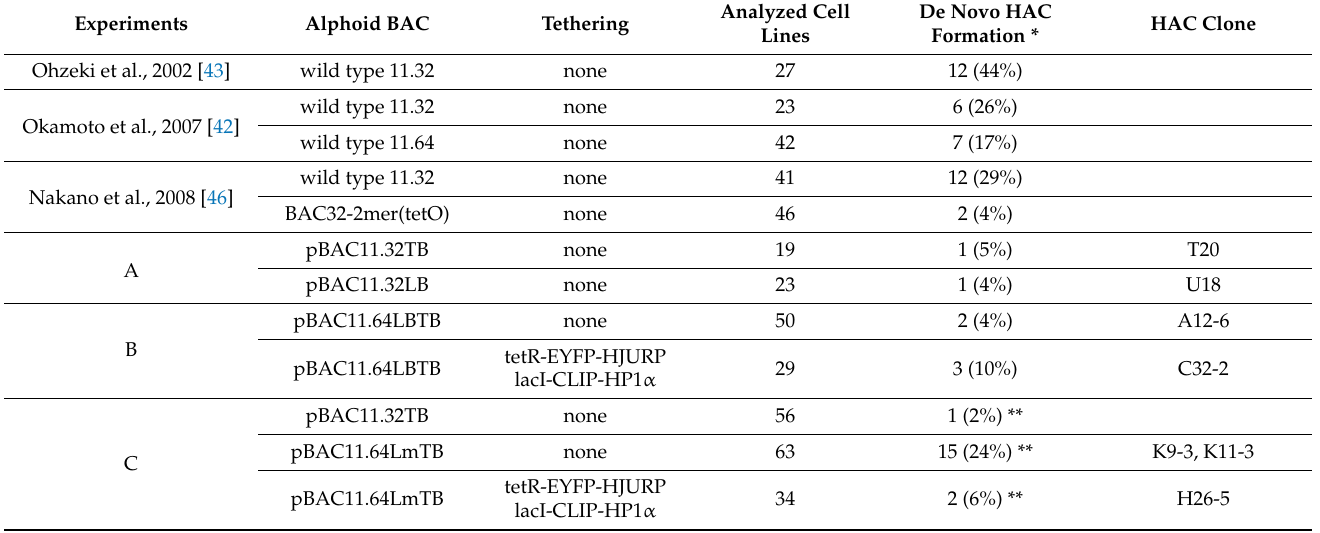
Table 1. De novo HAC formation efficiency by synthetic alphoid